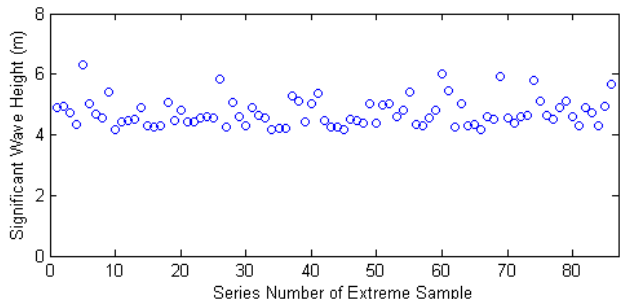
Figure 7. Sensitivity of the return significant wave heights to the thresholds (3.2–5.0 m) at location S1.